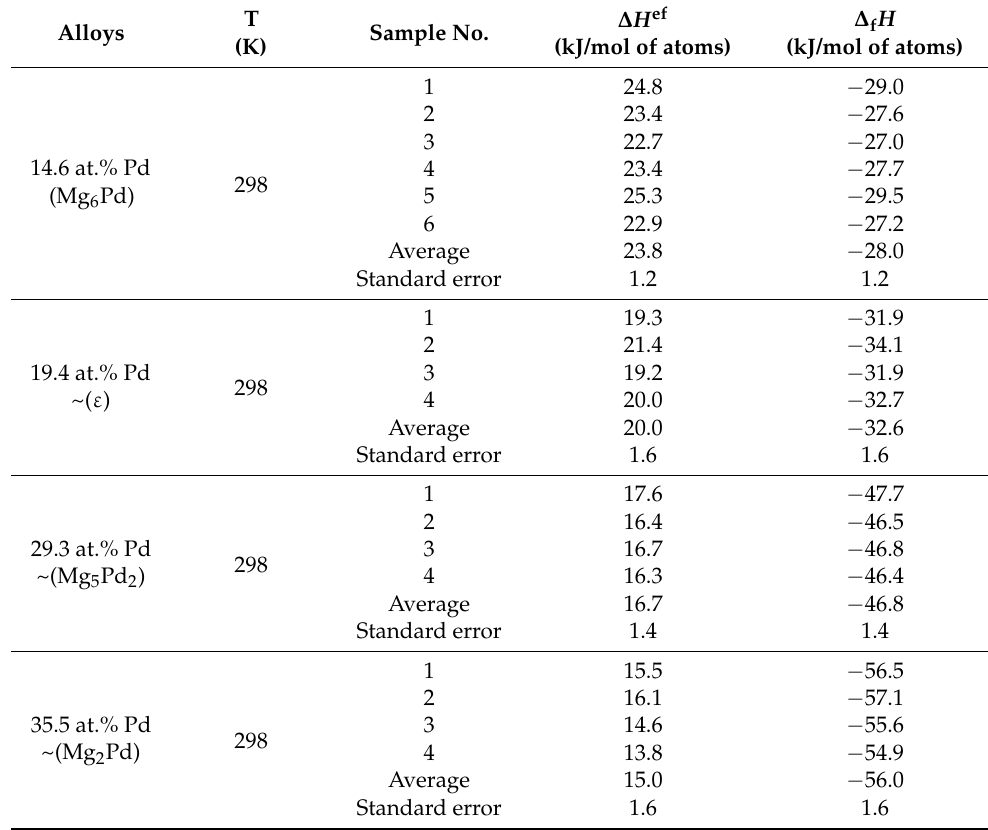
Table 5. Heat effects ∆ H ef of the solution and formation enthalpies ∆ f H of the intermetallic phases from the Mg-Pd system. The temperature of the Al bath was 1033